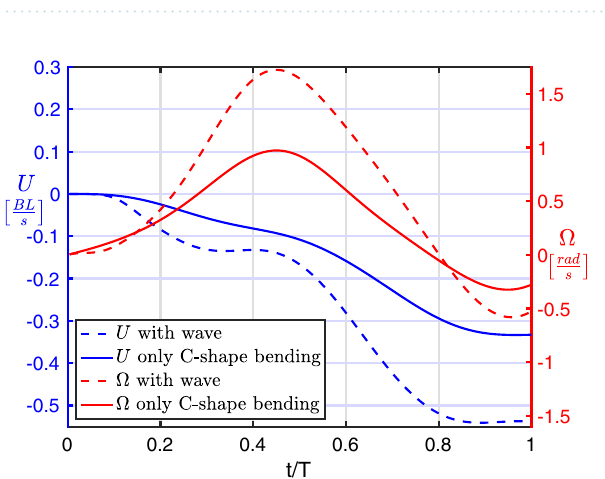
Figure 6. Snapshots of the C-start maneuver combined with a wave undulation from the numerical simulation. The relative animation is reported in the Movie S2.